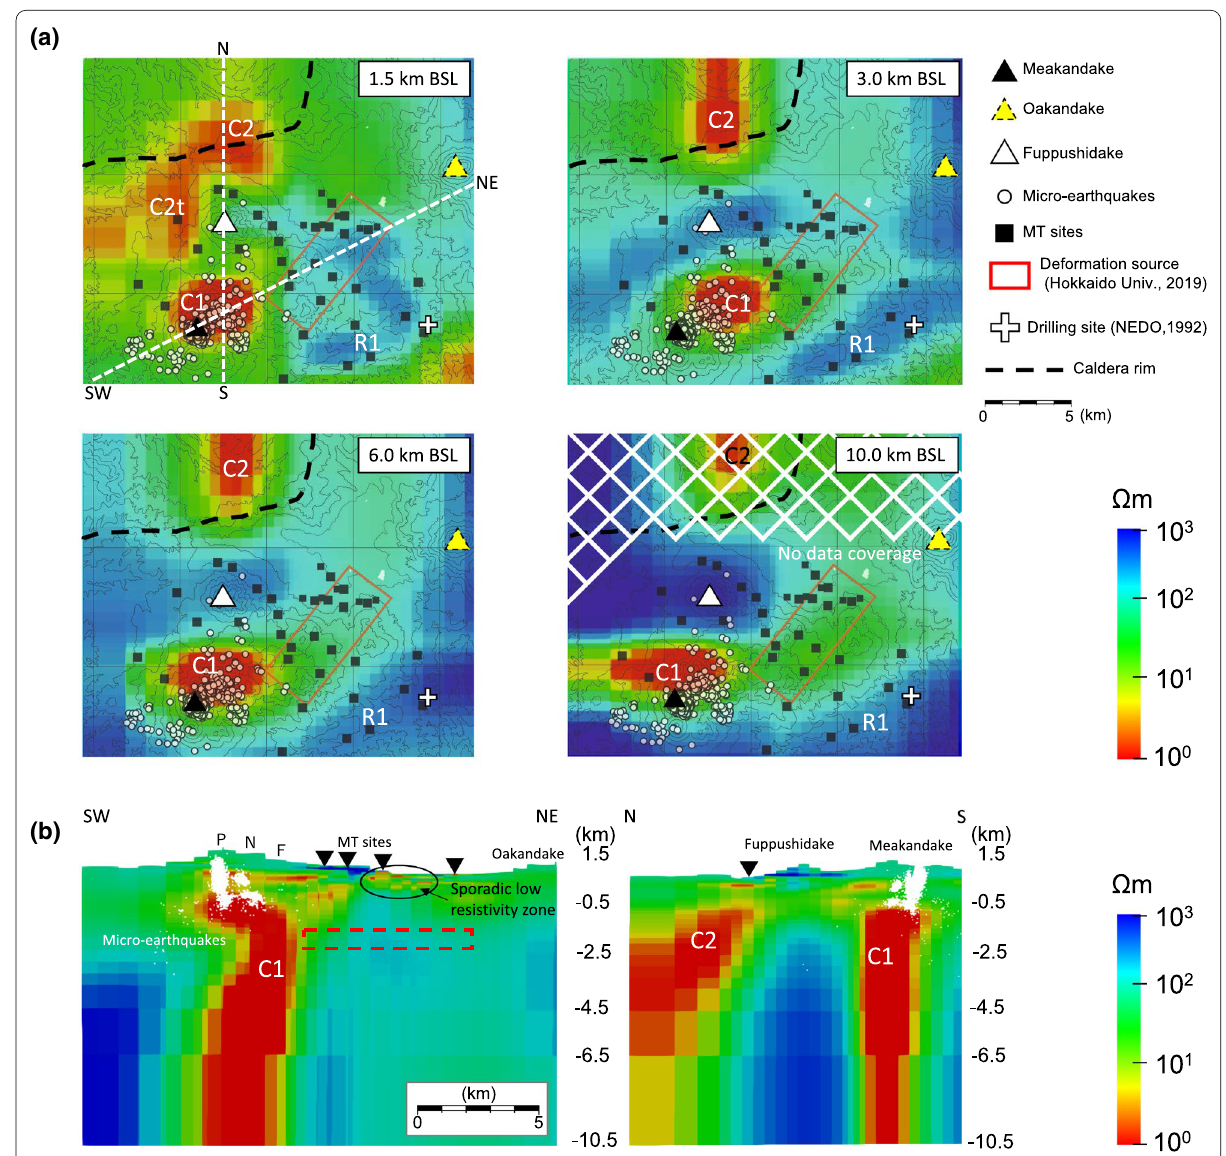
Fig. 3 a The final resistivity model sliced at 1.5, 3, 6 and 10 km BSL. Major features are labeled as C1, C2 and R1. b The resistivity model sliced along SW–NE and N–S lines, as shown in panel a . The red rectangles in panel a indicates the estimated deformation source by Faculty of Science, Hokkaido Univ. (2019). However, the source is shown by a dashed line in the cross section ( b ) as its thickness is unconstrained from the geodetic modeling. White dots indicate the hypocenters of volcanic earthquakes that occurred between 2004 and 2019 around Mt. Meakandake (provided by Sapporo Regional Headquarters, JMA). The symbols P, N, and F denote P and N craters, and a fumarolic area,